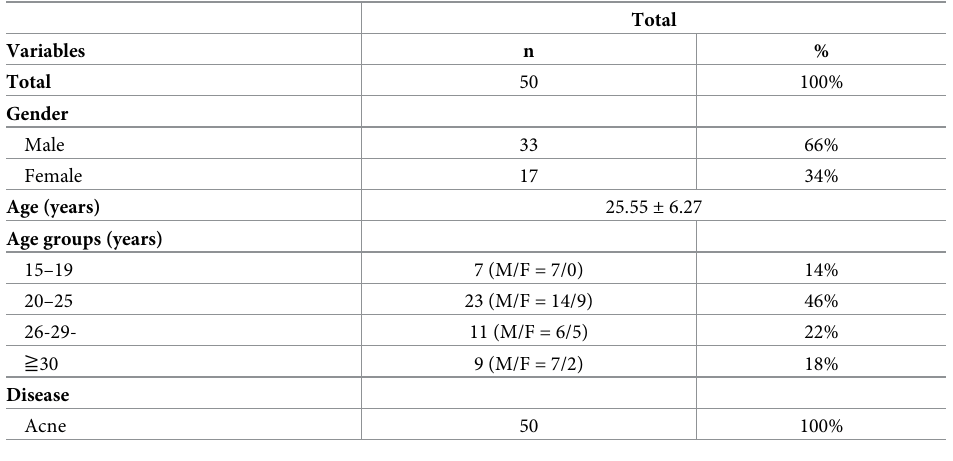
Table 1. Characteristics of study patients in the